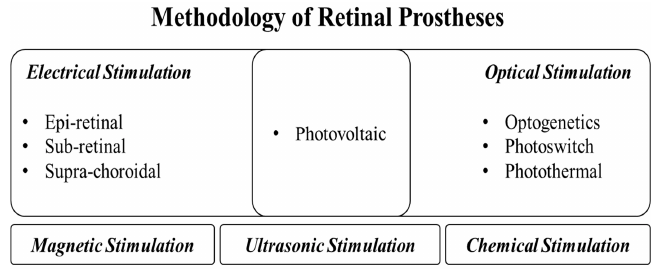
Figure 1. A summary of retinal prosthetic approaches for enhanced visual resolution.